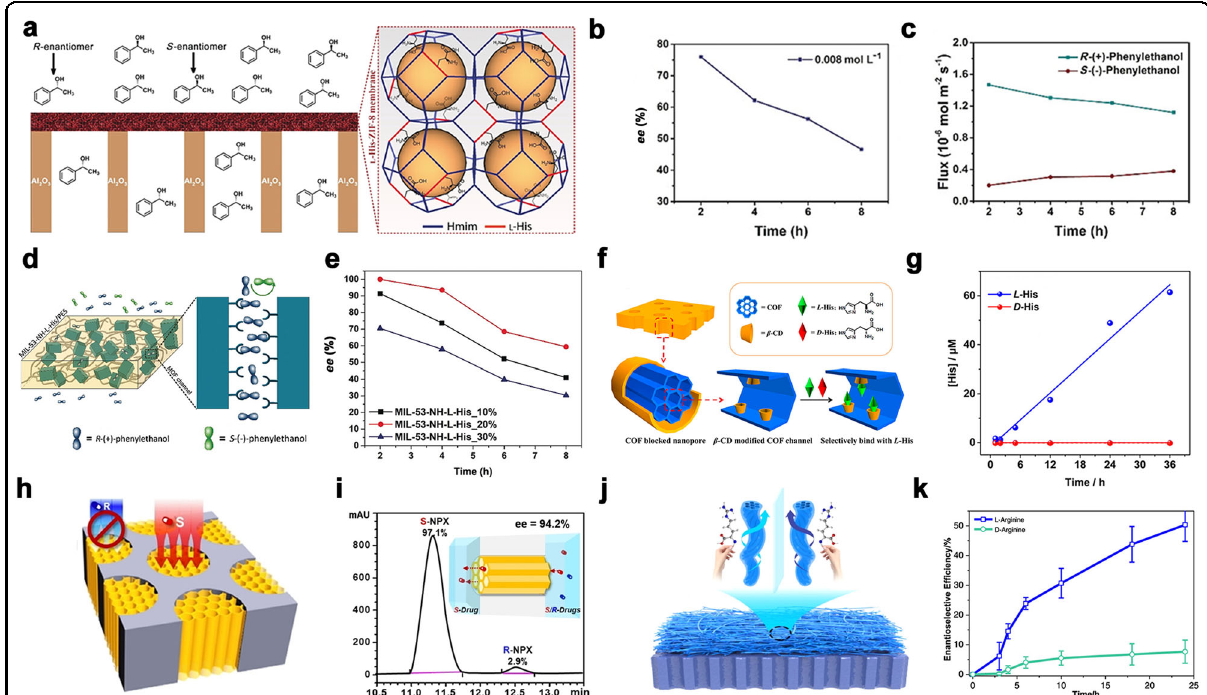
Fig. 8 Hierarchical nanochannel membrane for enantioseparation. a L-histidine-doped ZIF membrane on an AAO support (L-His-ZIF-AAO). Enantiomeric excess value ( b ) and concentration ( c ) of each enantiomer through L-His-ZIF-AAO vs . permeate time. Reproduced with permission 73 . Copyright 2018, Wiley-VCH. PES membrane containing amino acid-functionalized MIL-53 ( d ) and its separation performance evaluation ( e ). Reproduced with permission 74 . Copyright 2019, Wiley-VCH. f CD-COF-PES membranes built from the mixing of PES with chiral β -cyclodextrin- modi fi ed COF. g Concentrations of histidine in the permeate solution through the CD-COF-PES membrane vs . permeate time. Reproduced with permission 77 . Copyright 2019, American Chemical Society. h Schematic of an L-tyrosine-functionalized COF packed in a PET nanochannel (L-Tyr-COF- PET). i HPLC chromatogram of the separated naproxen with the L-Tyr-COF-PET membrane. Reproduced with permission 78 . Copyright 2022, Wiley- VCH. j , k Chiral mesoporous silica assembly on AAO support and its separation capacity toward L- and D-arginine. Reproduced with permission 32 . Copyright 2022, American Chemical